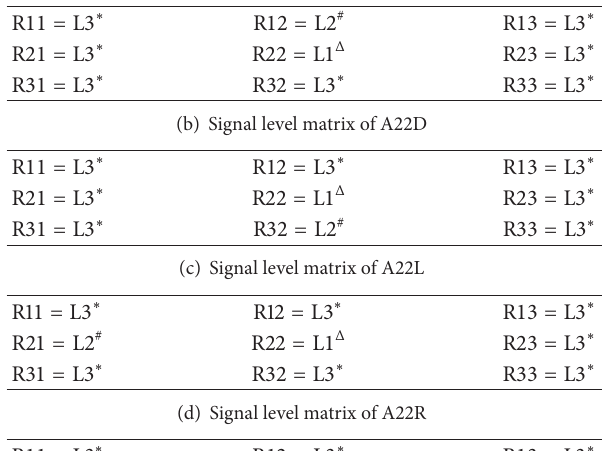
axis, the position of hospital bed can be determined based on the result of SLM.